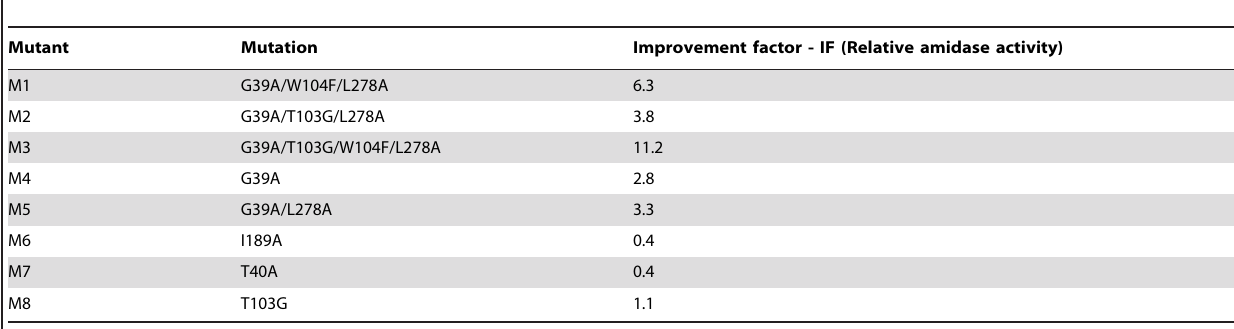
Mutant Mutation